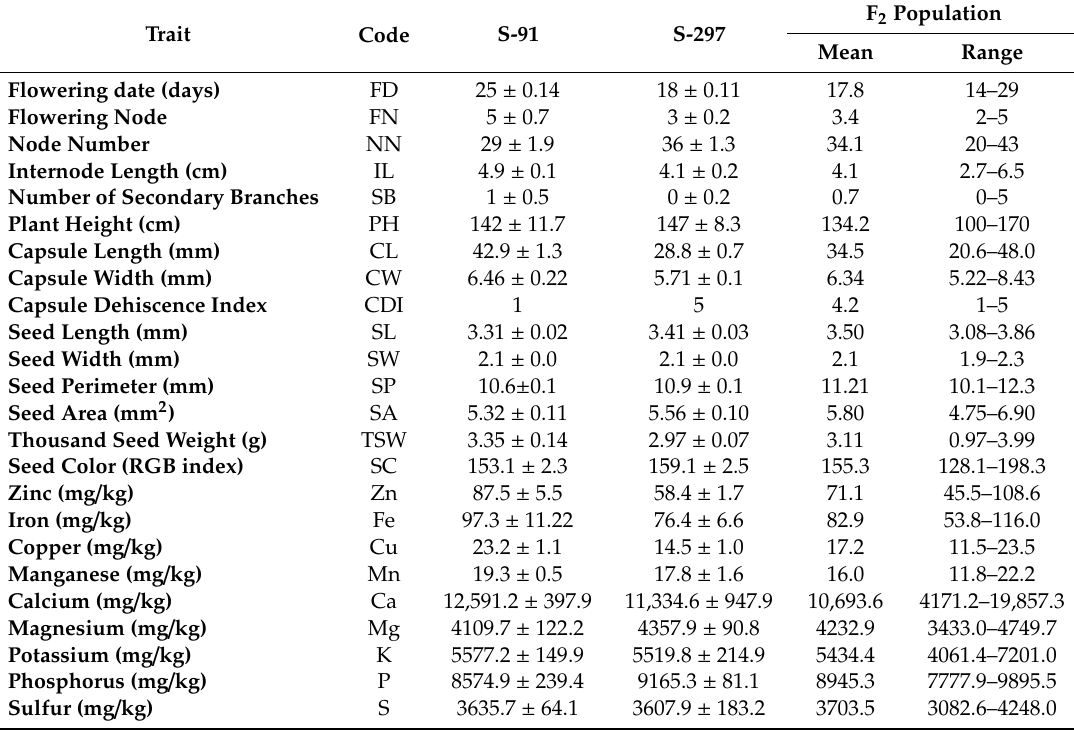
Table 1. Mean values and ranges of plant morphological traits and seed mineral-nutrient concentration of 149 F 2 lines (S-91 × S-297) as well as the two parental